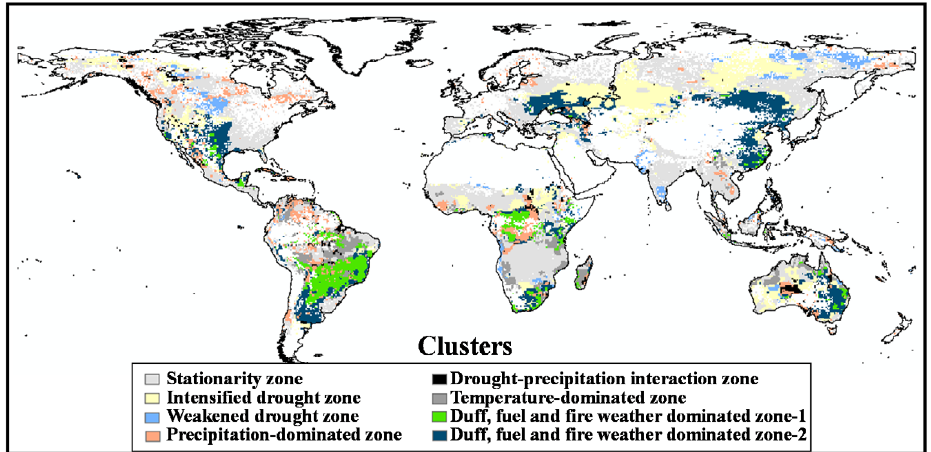
Fig. 12 Cluster map of the change-point dates and change trends among the six wildfire-related variables. This figure shows clustering of change-point dates and change trends, with different coloursindicating different wildfire weather characteristics. For example, the black areas of Australia inthe figure indicate that the wildfire weather in that region is controlled by drought and